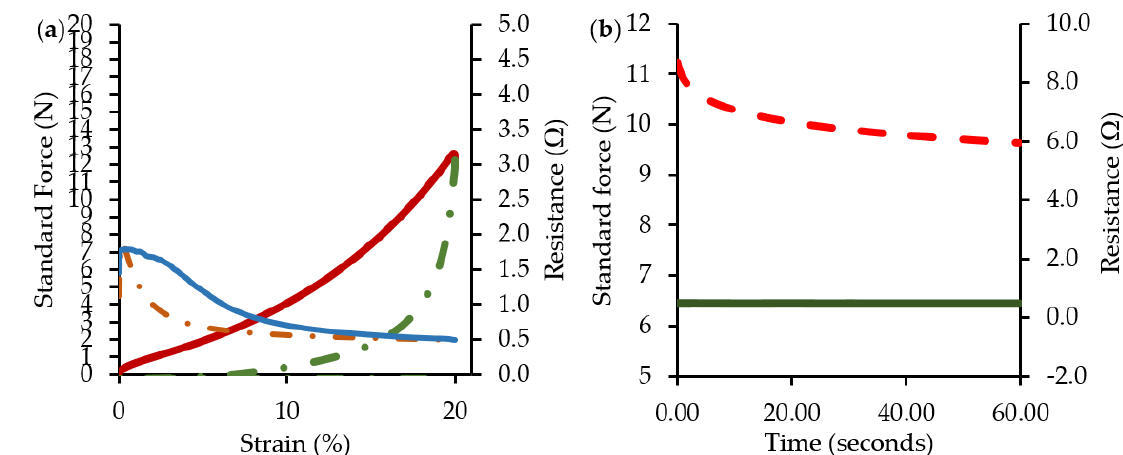
Figure 2. ( a ) Uniaxial tensile tests on a single knitted spacer electrode. Results are the average of five loading and unload- ing curves. The standard force (red and green lines) and resistance (blue and orange line) are both shown. Loading is shown with a solid line, and for unloading a dotted line was used. ( b ) Force degradation of the electrode when held at 20% strain for 60 s. Force presented by the red dotted line, with resistance shown by the green line.